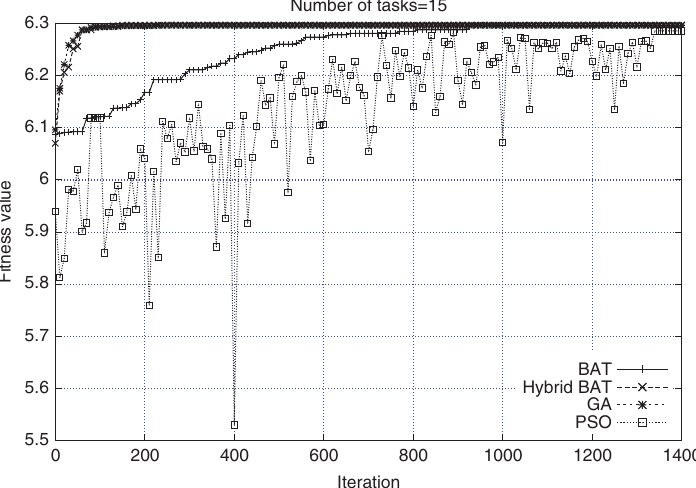
Figure 3: WS Composition – 15 tasks, 100 Candidate WSs.